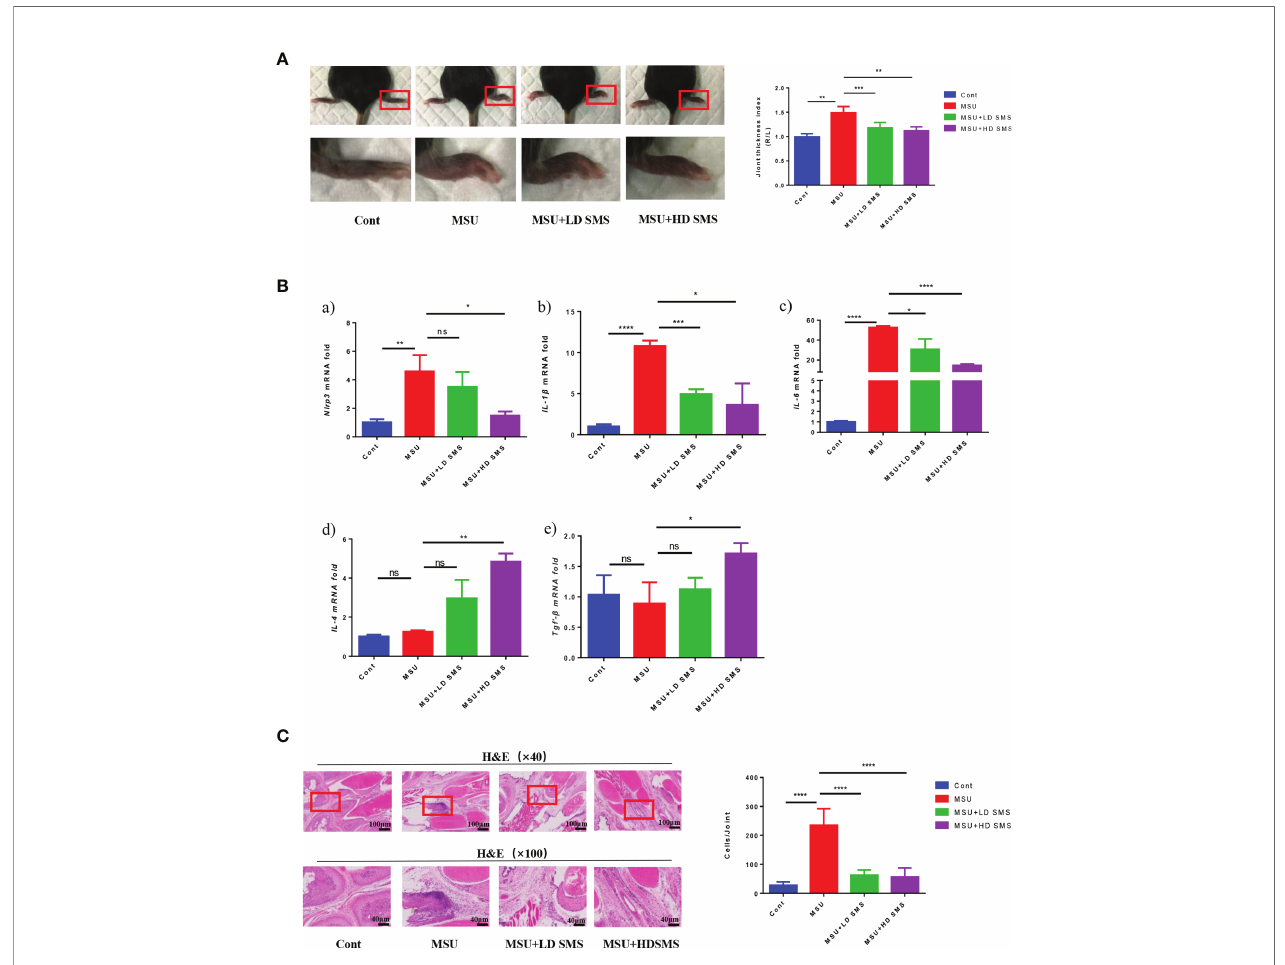
FIGURE 1 | SMS ameliorate MSU induced acute gouty arthritis in mice. Joint swelling and the joint thickness index at 8 hours after MSU injection in the mice (A) . The mRNA expression of Nlrp3 , IL-1 b , IL-6 , IL-4 , Tgf- b in the injured joints of the mice (B) . H&E staining, and in fl ammatory cells in fi ltration in the joints (C) . (mean ± SEM. ns p > 0.05, *p < 0.05, **p < 0.01, ***p < 0.001, ****p < 0.0001; n = 6/group; LD SMS: 1mg/kg.day low dose SMS; HD SMS:10mg/kg.day high dose